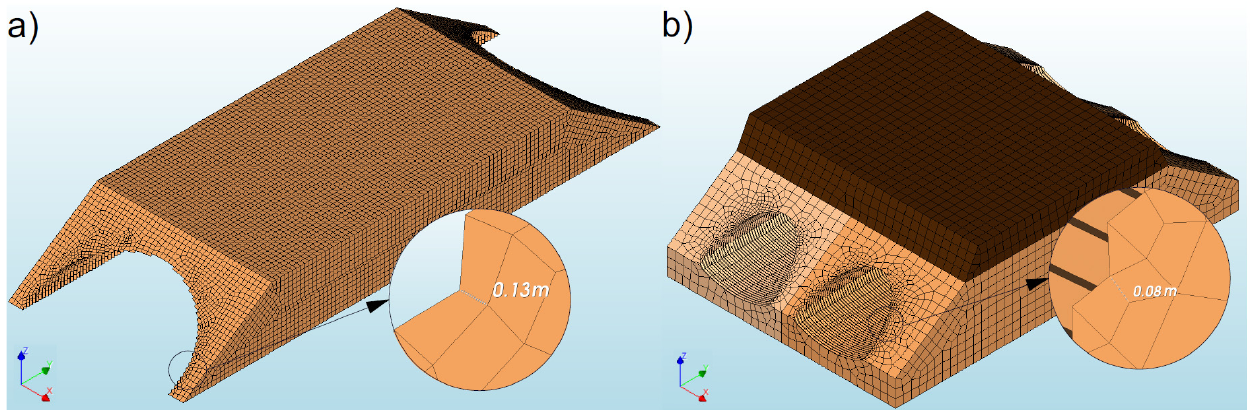
Figure 8. View of FEM models of the analysed bridges: ( a ) #1, ( b ) #2. Table 1. Material properties of soil–steel composite bridges.